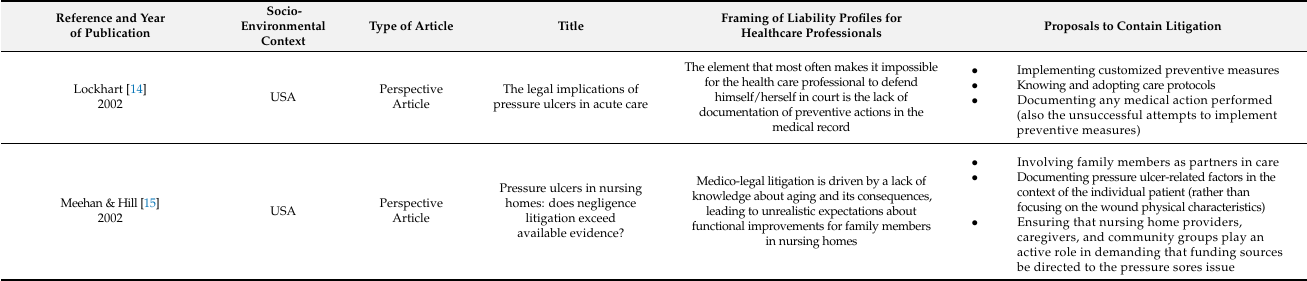
Table 2. Summary of the content of the 12 articles included in the